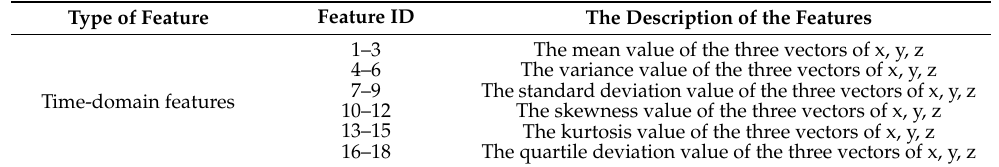
Table 1. The extracted features in this